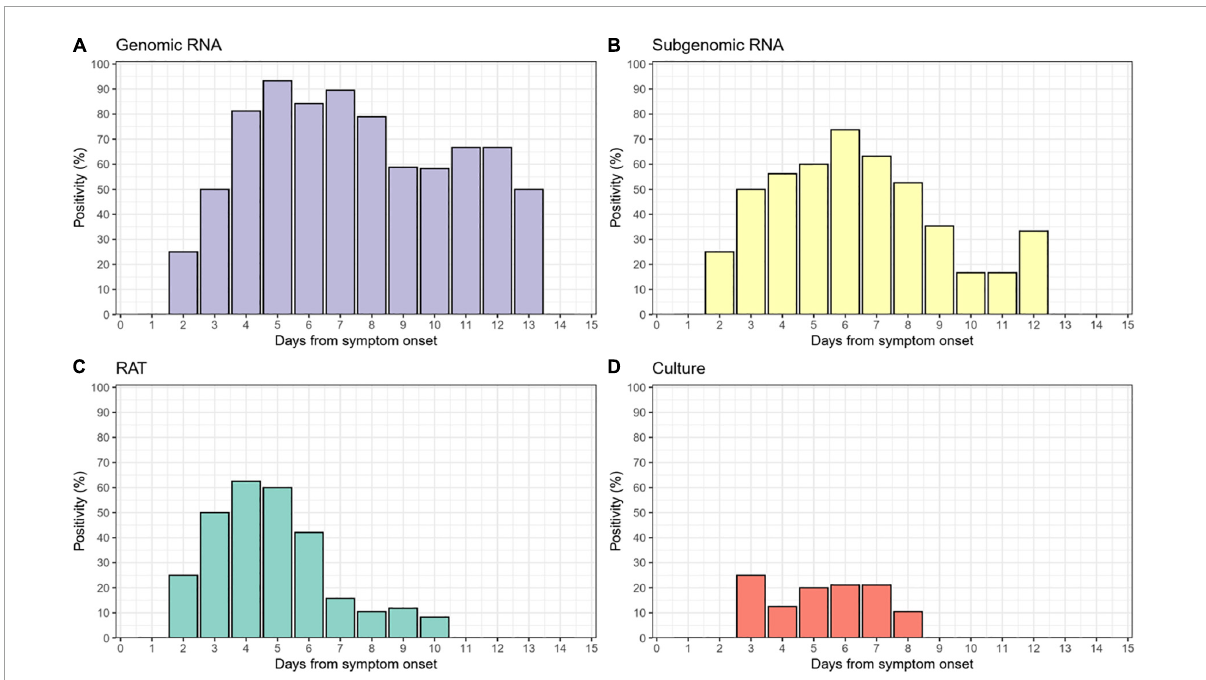
FIGURE1 Daily positivity of (A) genomic RNA, (B) subgenomic RNA, (C) rapid antigen test (RAT), and (D) cell